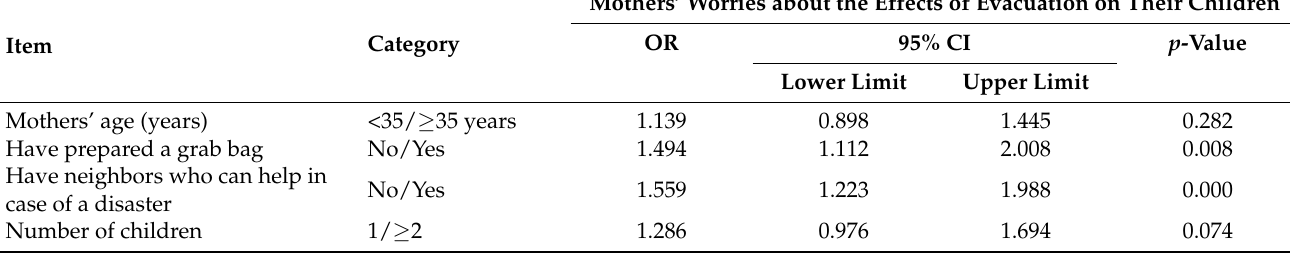
Table 4. Factors related to mothers’ worries about the effects of evacuation on their children ( n =